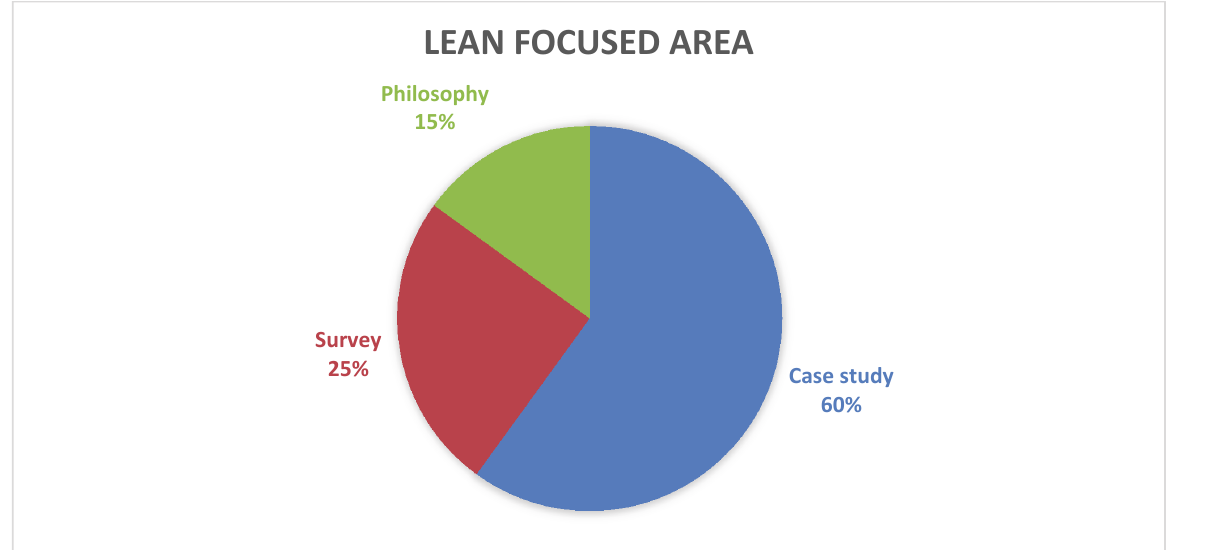
Fig. 3. Lean focused area